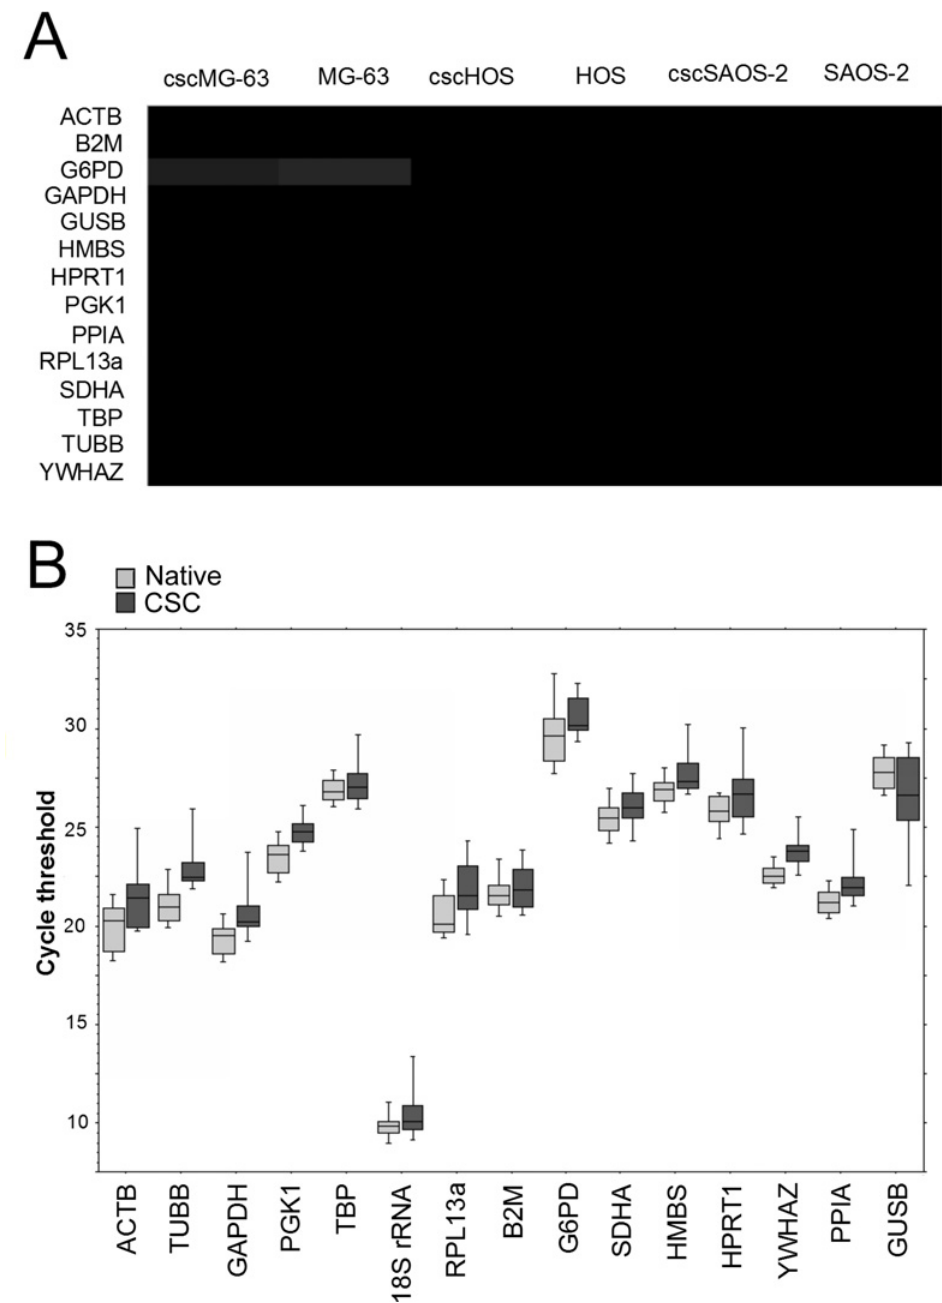
Fig 2. Transcription profiling of the selected reference genes. (A) Heat map showing the relative expression of the selected genes in native cells and CSC from MG-63, HOS, and SAOS-2. (B). Transcriptional profile of Cycle threshold (Ct) values of candidate HKG genes in CSC and native cell lines. Boxes represent lower and upper quartiles of cycle threshold range with the median indicated, vertical bars represent the 10 th and 90 th percentiles. In both CSC and adherent cell lines, 18S rRNA was the most highly expressed gene (lower Ct value), whereas G6PD was the least expressed gene (highest Ct